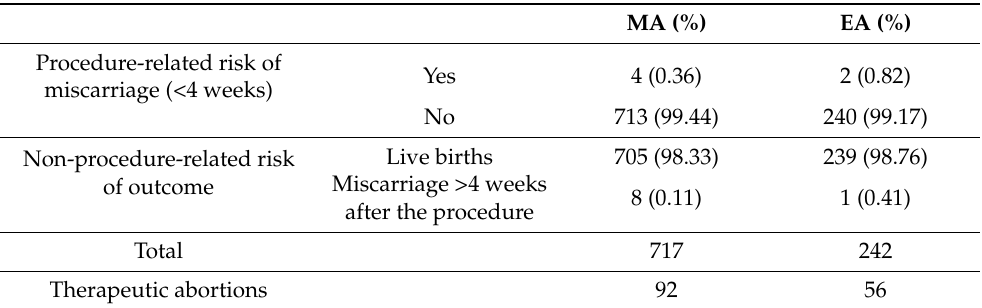
Table 3 summarises the pregnancy outcomes. Table 3. Primary outcomes.